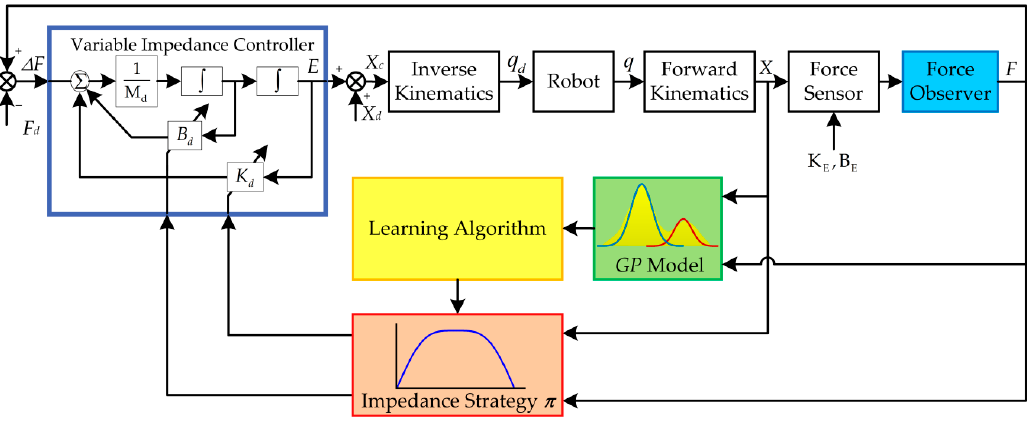
Figure 5. Scheme of the data-efficient learning variable impedance control.